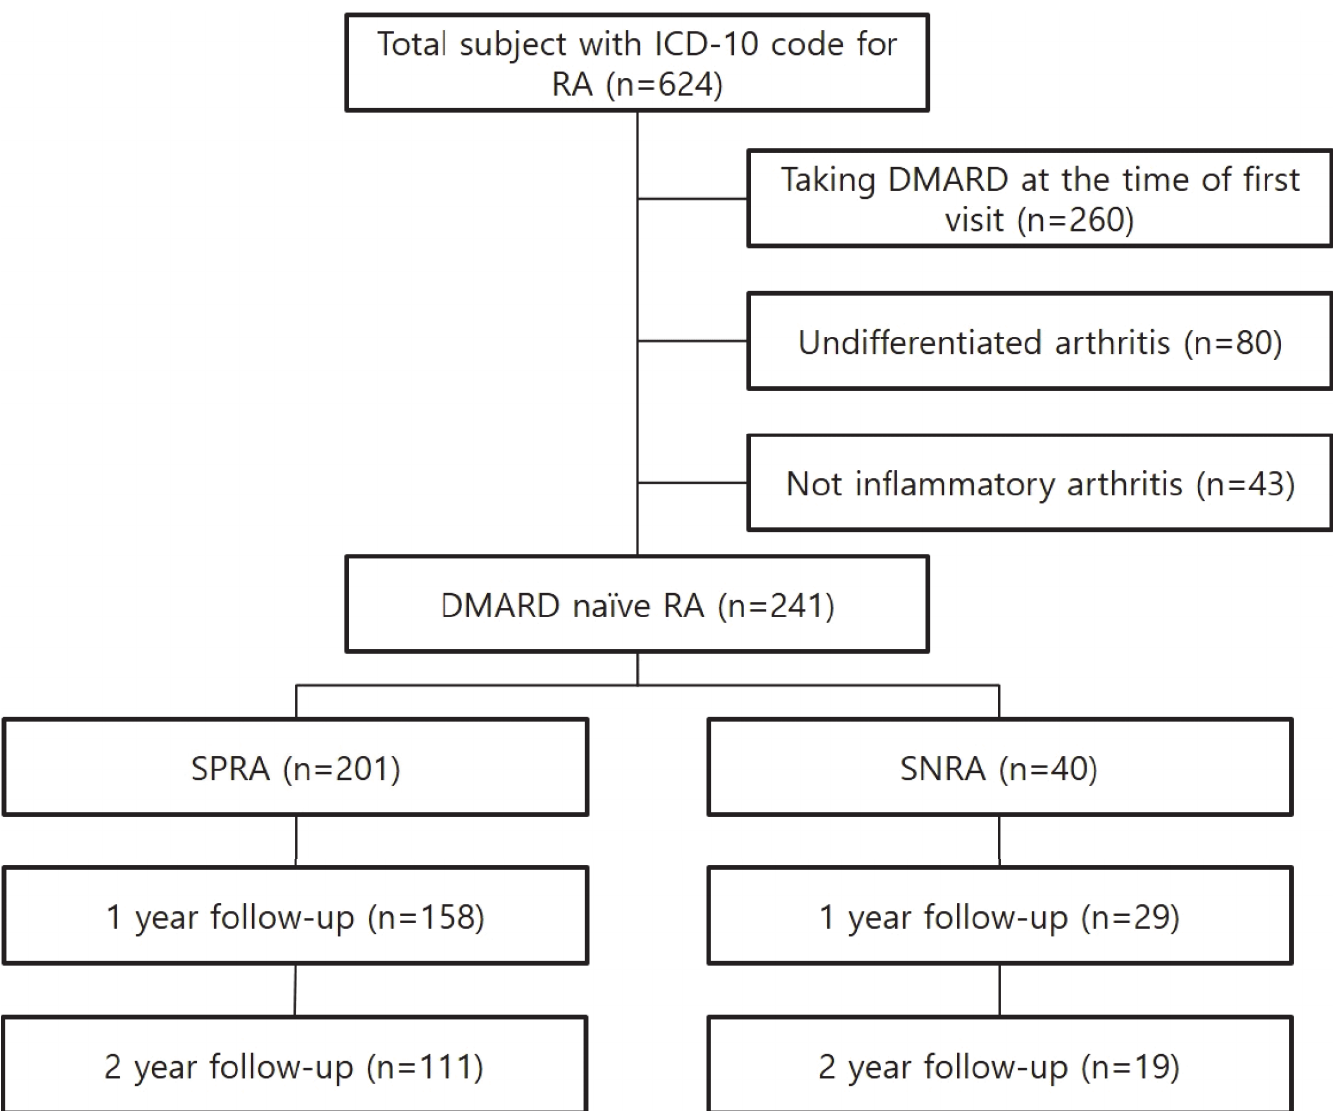
Fig 2. Disease activity measures (ESR, CRP, 28TJC, 28SJC and DAS28-ESR) all improved in both groups over the 2 years of treatment with DMARDs. Box plots for each disease activity measures at baseline, 1 year and 2 years after are displayed for each group (SNRA and SPRA). All the measures improved from baseline on both groups after treatment with DMARDs. DMARD: disease modifying antirheumatic drug, ESR: erythrocyte sedimentation rate, CRP: C-reactive protein, TJC: tender joint count, SJC: swollen joint count, DAS28-ESR: disease activity score 28 ESR. https://doi.org/10.1371/journal.pone.0195550.g002 SNRA—1.97±0.95 vs. -2.40±0.85, p = 0.097). Comparison among low disease activity popula- tion was not possible because none of the SNRA patients was with low disease activity. Inter- group differences over 2 years were not significant in ESR, CRP and DAS28 values, while sig- nificant in 28 TJC ( p = 0.019) and 28 SJC ( p = 0.014). DAS28-ESR remission rate was similar between the 2 groups (1 year: SNRA 21/29 (72.4%) vs. SPRA 95/158 (60.1%), p = 0.298, 2 years: SNRA 14/19 (73.7%) vs. 67/113 (59.3%), p = 0.311). Radiologic outcomes assessed by plain radiographs of the affected joints at baseline and follow-up were also similar. No signifi- cant differences were found between the 2 groups in terms of the proportion of patients with joint space narrowing or erosion at baseline (SNRA 5/21(23.8%) vs. SPRA 48/182 (26.4%), p =